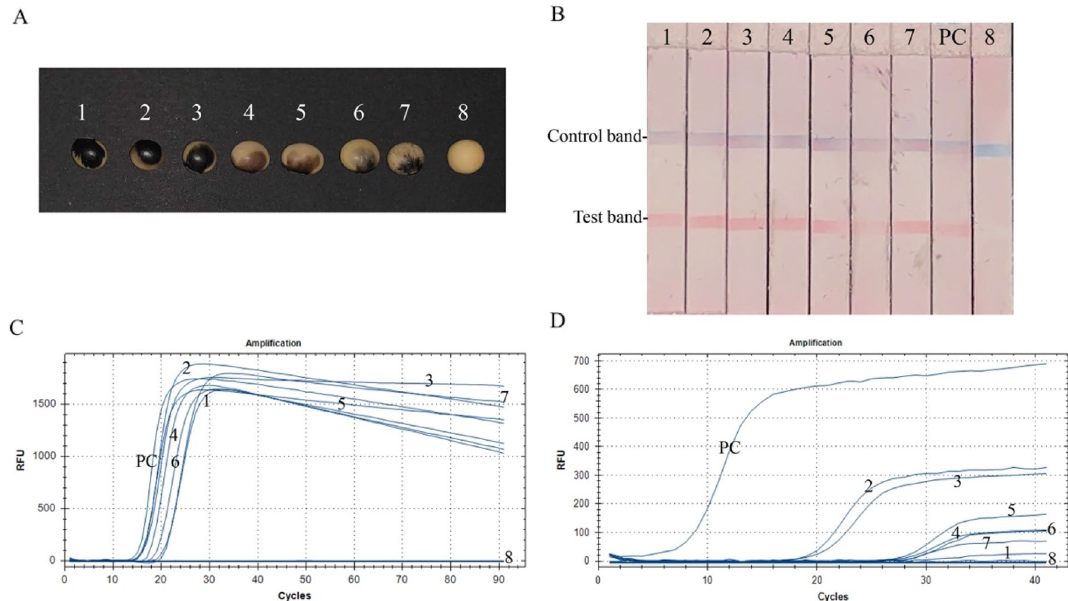
Figure 3. Validation of the BPMV detection methods on field samples. ( A ) Soybean seeds. 1–7, imported soybean seeds with suspected symptoms of BPMV infection; 8, healthy soybean seed from a local supermarket. ( B – D ) Detection of BPMV by RT-CPA-LFD, real-time fluorescent RT-CPA, and TaqMan-MGB real-time RT-PCR. PC, positive control of the RNA template from the BPMV-infested leaves. NC, negative control (a healthy soybean